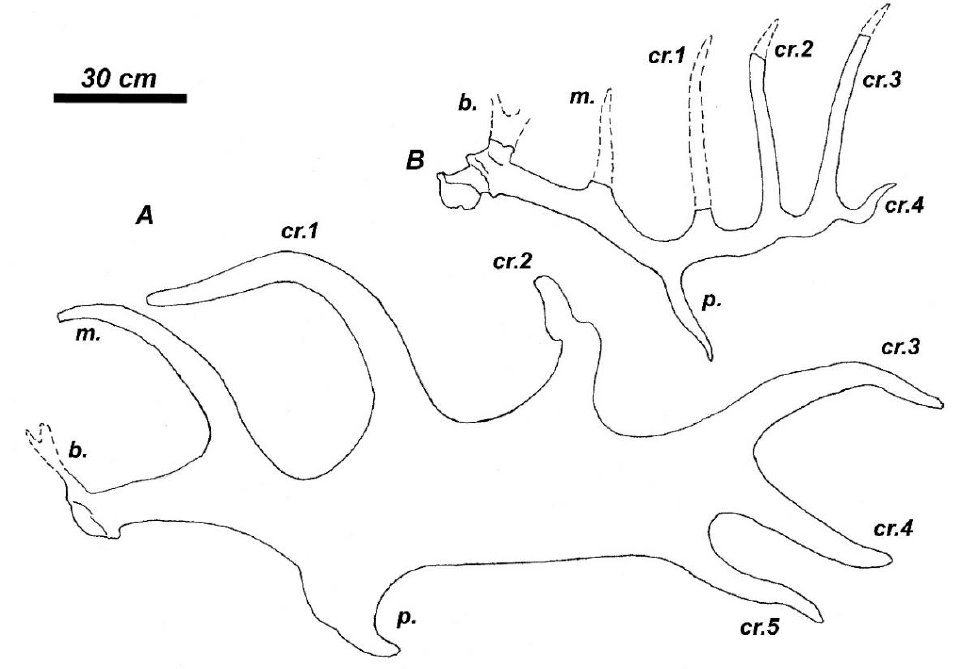
Figure 3. Antler bauplan of Megaloceros and Praedama : ( A ), Megaloceros giganteus giganteus from Bucharest environs, Romania (adapted from Apostol [59]); ( B ) Praedama sp. from Pinedo, Spain (adapted from Aguado [60]). Abbreviations: b., basal tine; m., middle tine; p., posterior tine; cr., crown tine.